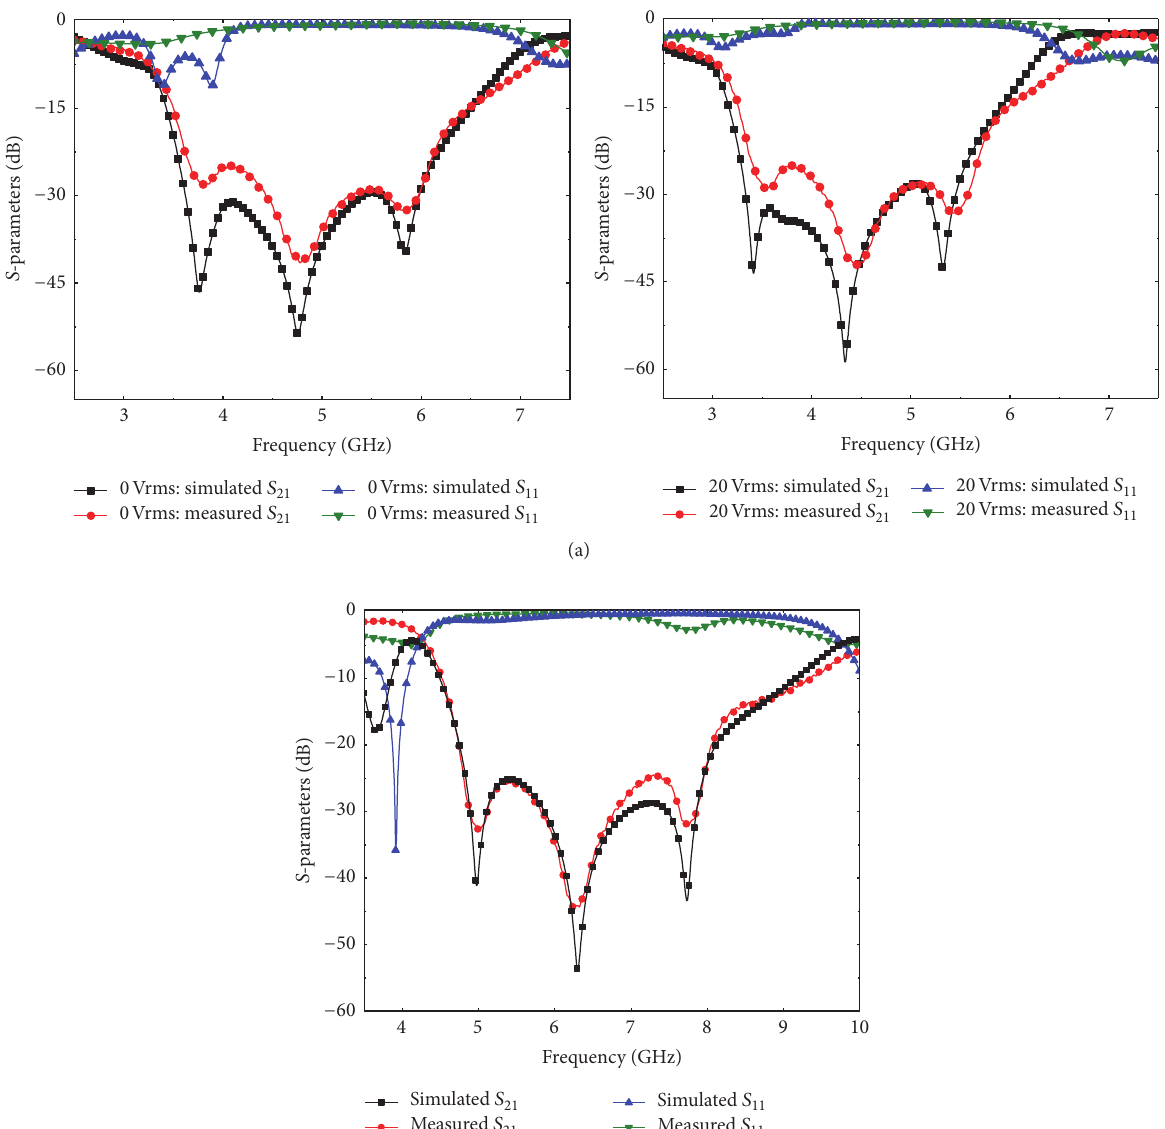
Figure 10: Comparison between the simulation and measurement results of the proposed BSF: (a) LC as the substrate and (b) air as the substrate (before LC injection).